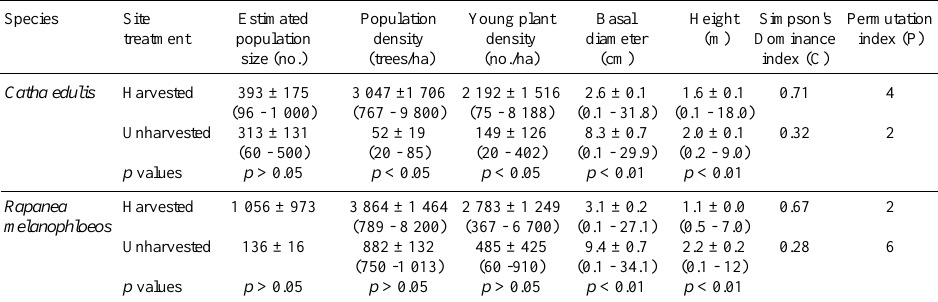
Table 1 Population parameters (Mean ± SE ) of harvested and unharvested Catha edulis and Rapanea melanophloeos populations (Range is provided in brackets below the mean) Species Site Estimated Population Young